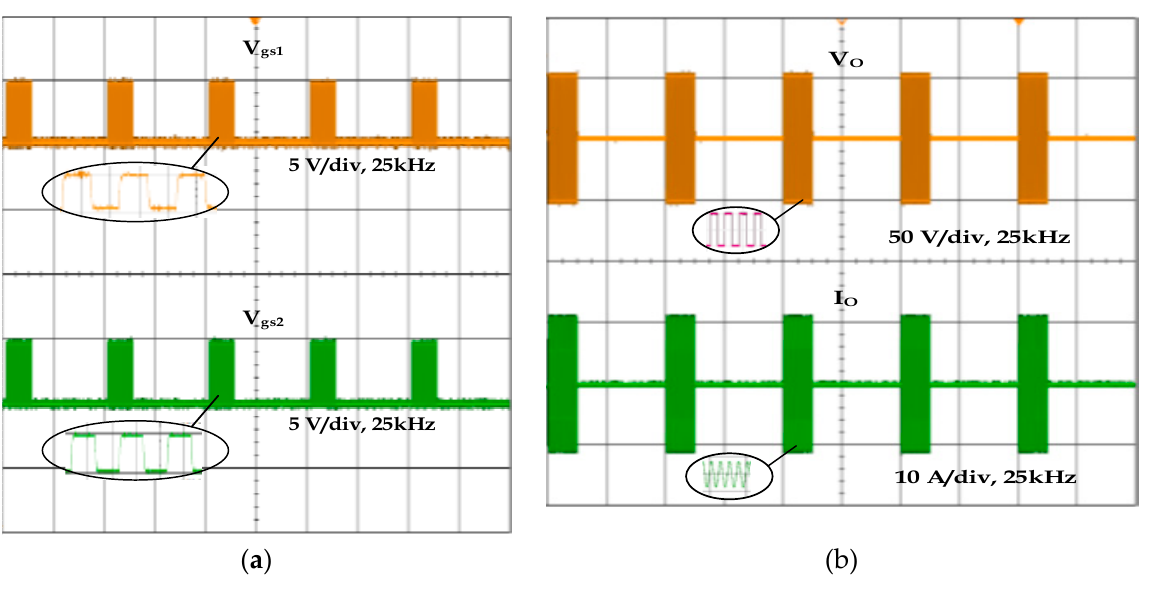
Figure 15. Experimental waveforms of Mode 4 with 25% PDM: ( a ) switching pulses and ( b ) output voltage and current.